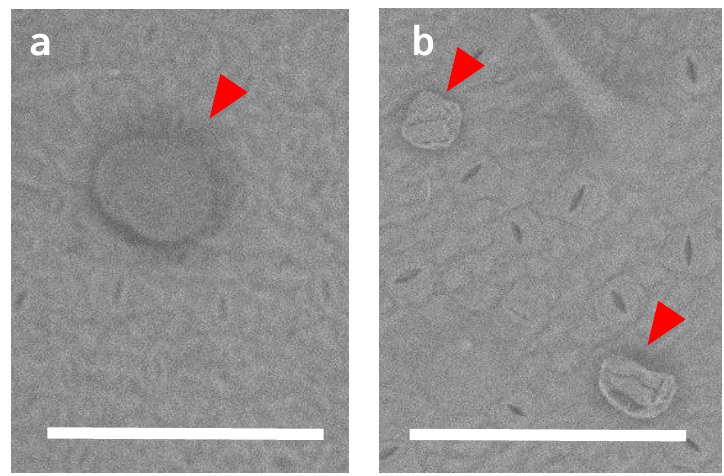
Figure 7. LVSEM images of glandular trichomes on the yacón leaf surface ( a ) before DCM rinse and ( b ) within a few seconds after DCM rinse (bar: 100 µm).